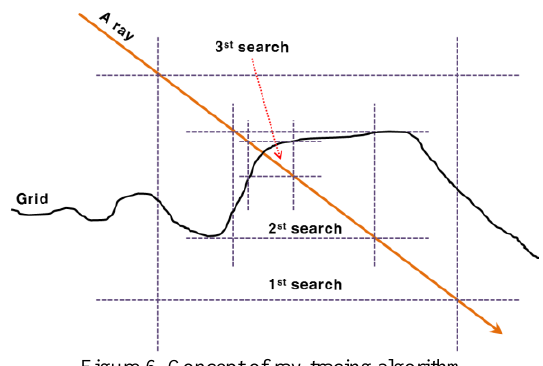
Figure 6. Concept of ray-tracing algorithm